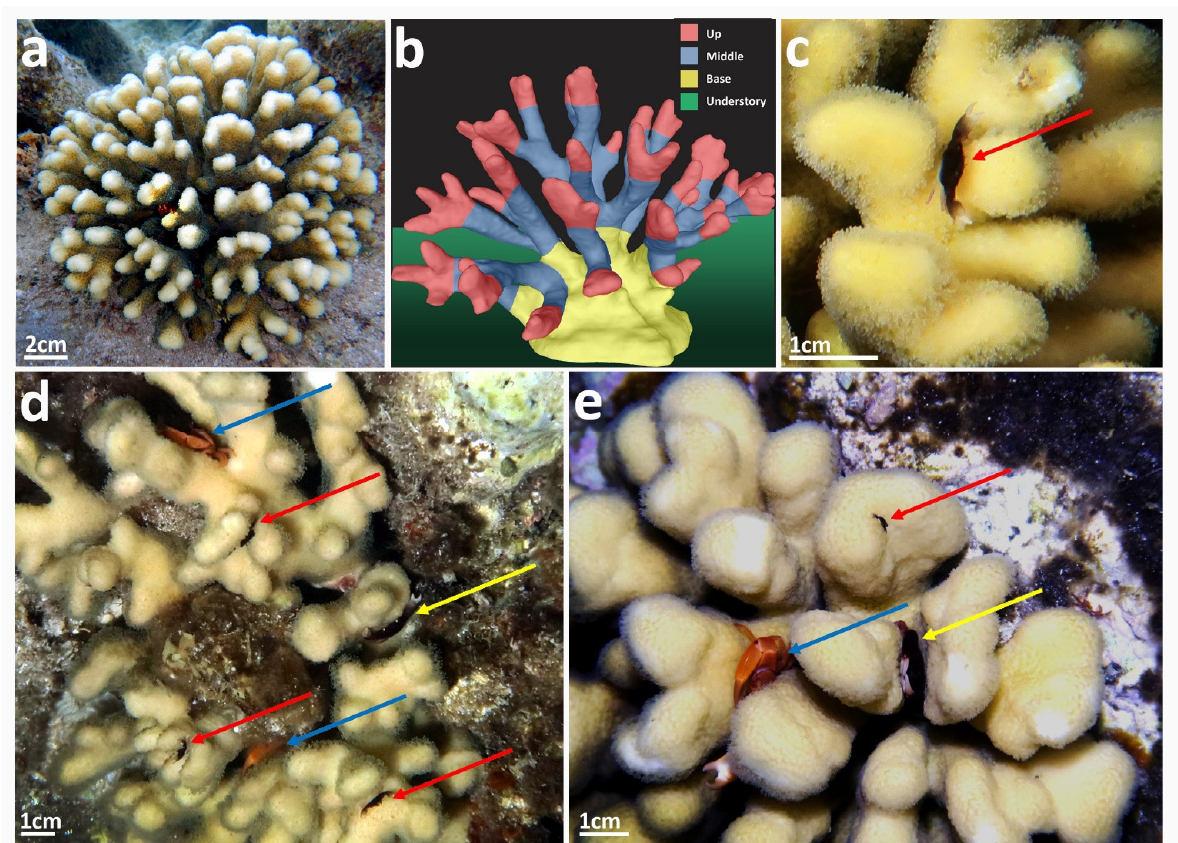
Figure 1. ( a ) Stylophora pistillata from Eilat’s reef at day time (3 m depth); ( b ) Schematic illustration of S. pistillata sagittal section for the canopy compartments. Up: the upper most parts of the canopy, that border the ‘outer-colonial’ environment. This compartment outlines the canopy’s internal volume and encloses the first Strahler order branches; Base: the coral most inner part composed by the canopy’s two highest Strahler numbers for each individual coral colony; Middle: inner branches area, a space enclosed between the branches above the base and below branches of the first Strahler order; Understory: the 3D volume exists at the edge of the coral canopy’s base and occupies the spaces between the coral’s substrate plain to the parallel first canopy branches that shade on it; ( c ) Trapezia digitalis small body size at the up compartment, night time; ( d , e ) Trapezia cymodoce and T. digitalis distribution among S. pistillata canopy compartments at night, respectively. Arrows: Red— small T. digitalis at ‘Up’ compartment; Yellow—medium T. digitalis at ‘middle’ compartment; Blue— large T. cymodoce at ‘Base’ compartment.